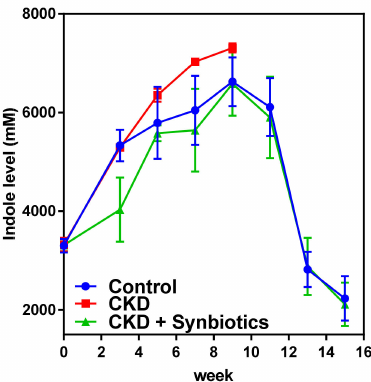
Figure 8. The time-series level of rat fecal indole in animal model 2. The fecal indole content in controls, CKD rats, and synbiotics-treated CKD rats. Adenine treatment causes animal death in the 10th week. n = 6 for each